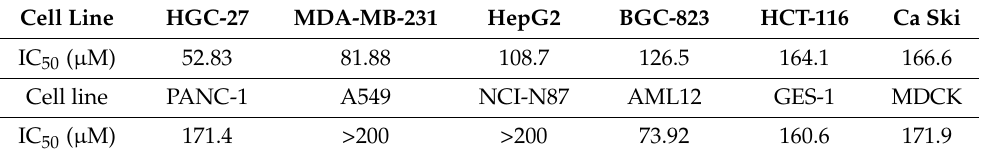
Table 1. The cytotoxic activity of polyacetylene 1 against tumor cell lines and normal cell lines. Cell Line